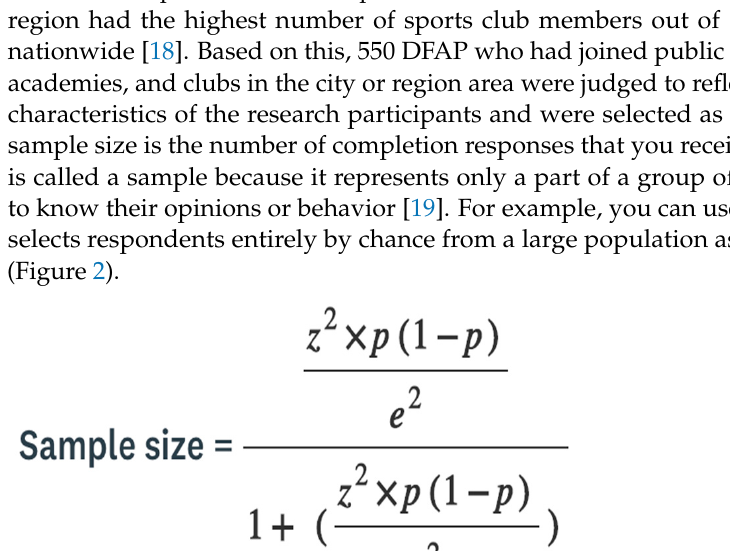
Table 1. Demographic characteristic of participants.